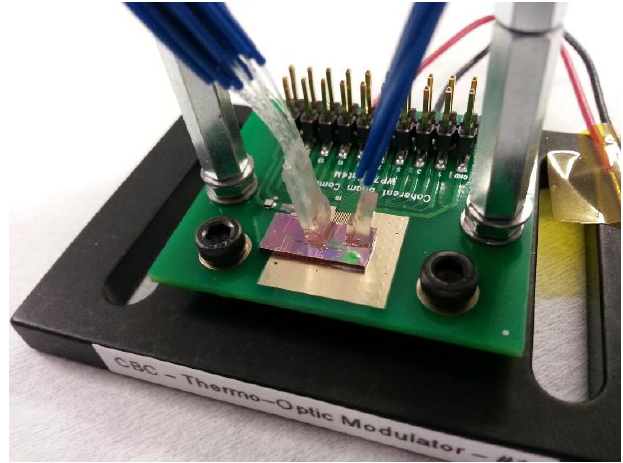
Figure 5. Photo of the coherent beam combining (CBC) prototype. The Si-PIC is housed onto a custom printed circuit board (PCB) and two fibre arrays are aligned and attached on top of the Photonic Integrated Circuit (PIC) using ultraviolet cure epoxy.